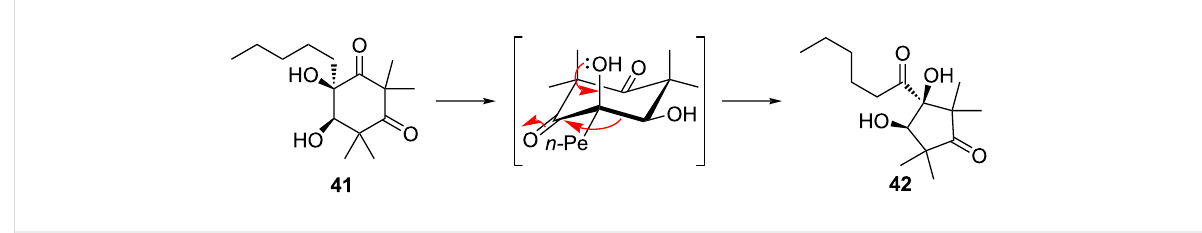
Figure 10: α -Ketol rearrangement of triumphalone ( 41 ) to isotriumphalone ( 42 ) via ring contraction.